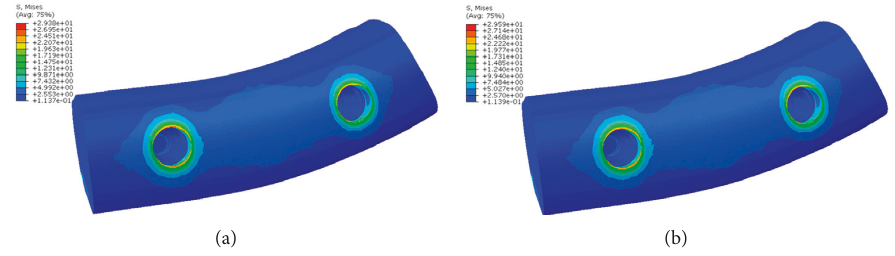
Figure 3: Stress distribution in bone in model 1. (a) PFBM. (b)